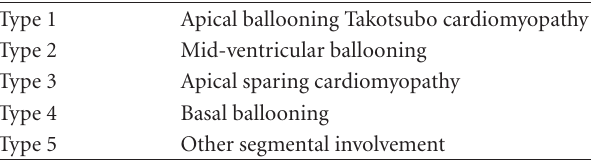
Table 2: Transient venticular cardiomyopathies